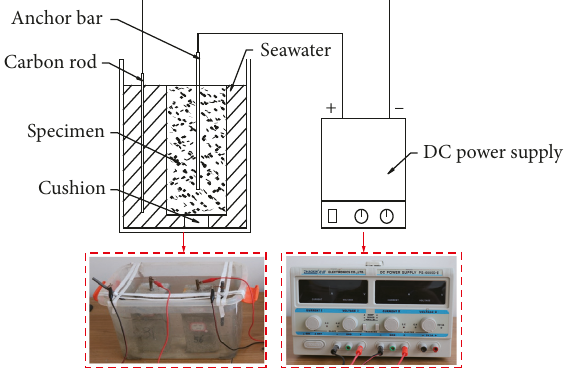
Figure 4: Accelerated corrosion device. Table 2: Factor loading matrix.